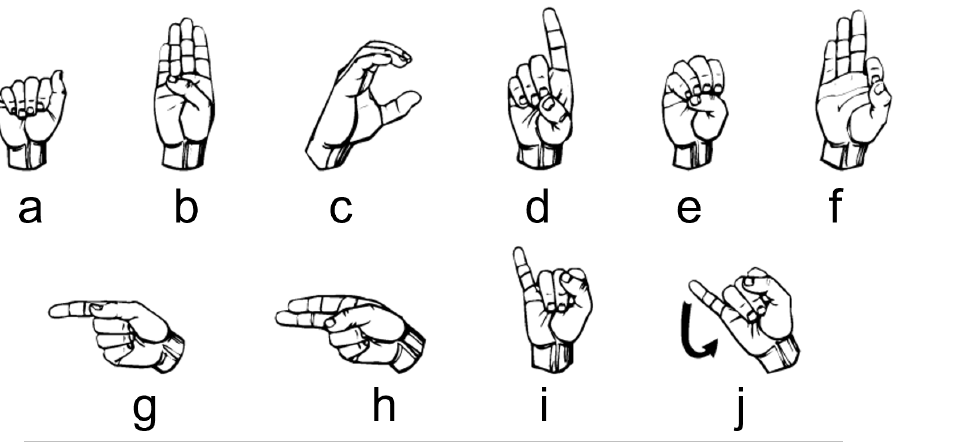
Figure 8. Ten ASL letters,